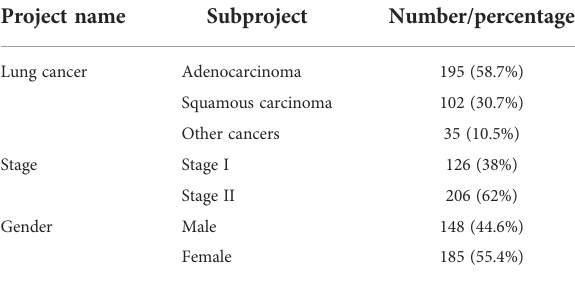
TABLE 2 Information on lung cancer samples in the training